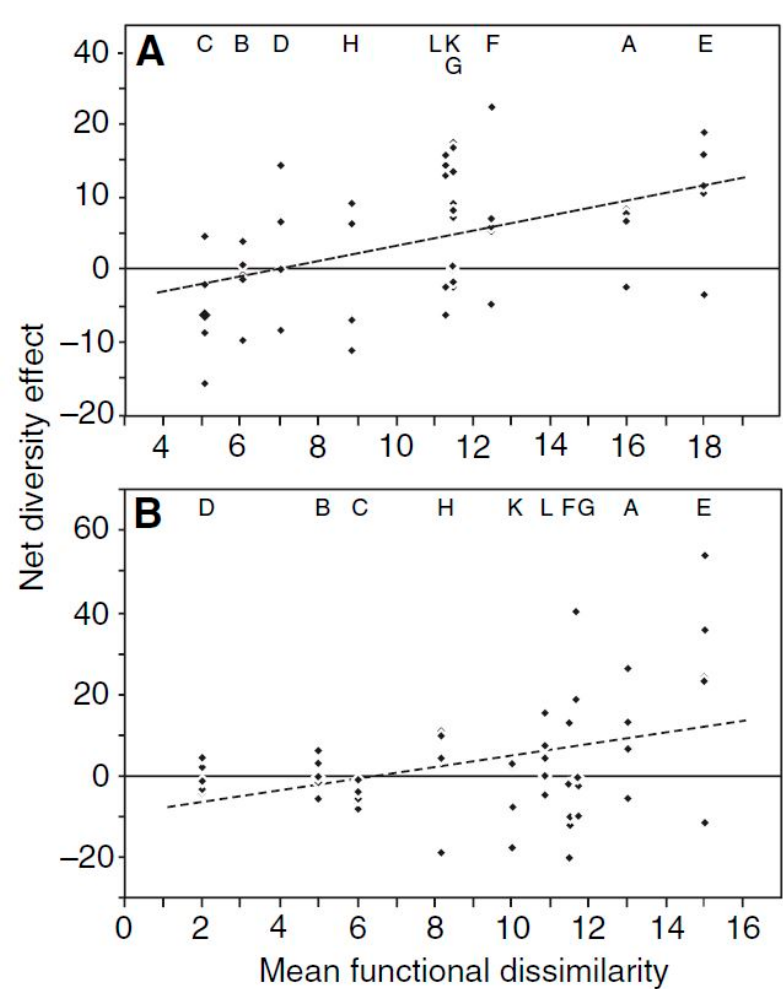
Figure 1. Net diversity effect on soil respiration ( A ) and leaf litter mass loss ( B ) in relation to mean functional dissimilarity of the species in the community. Each series of dots represents a treatment ( n = 5 replicates per treatment; some dots overlap). Letters at the top of the figure refer to the species combination given in Table S1 (See [14]); Supporting Online Material). A significant positive regression between the mean functional dissimilarity of the communities and the net diversity effect for soil respiration (linear regression, F 47,46 = 11.97, p = 0.001) and leaf litter mass loss (linear regression, F 47,46 = 7.48, p = 0.009) indicates that positive net diversity effects are more pronounced in communities consisting of functionally dissimilar species. Functional dissimilarity was related to neither species number nor taxonomic group number. From [14]. Reprinted with permission from AAAS.